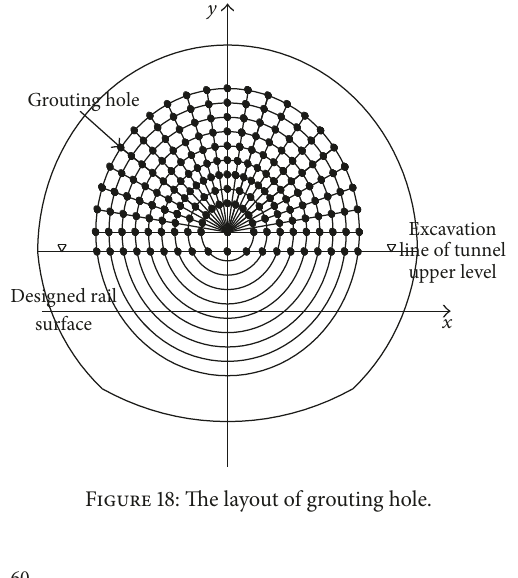
Figure 20: Grouting pressure of grouting